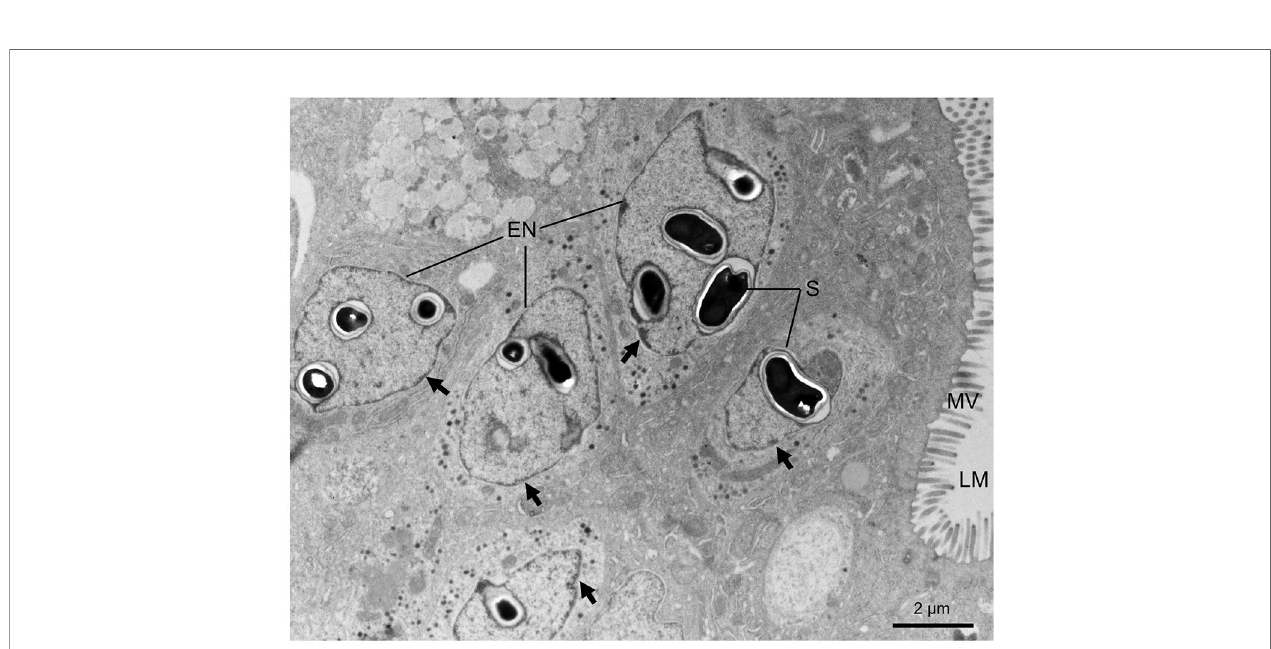
enterocyte nucleus.